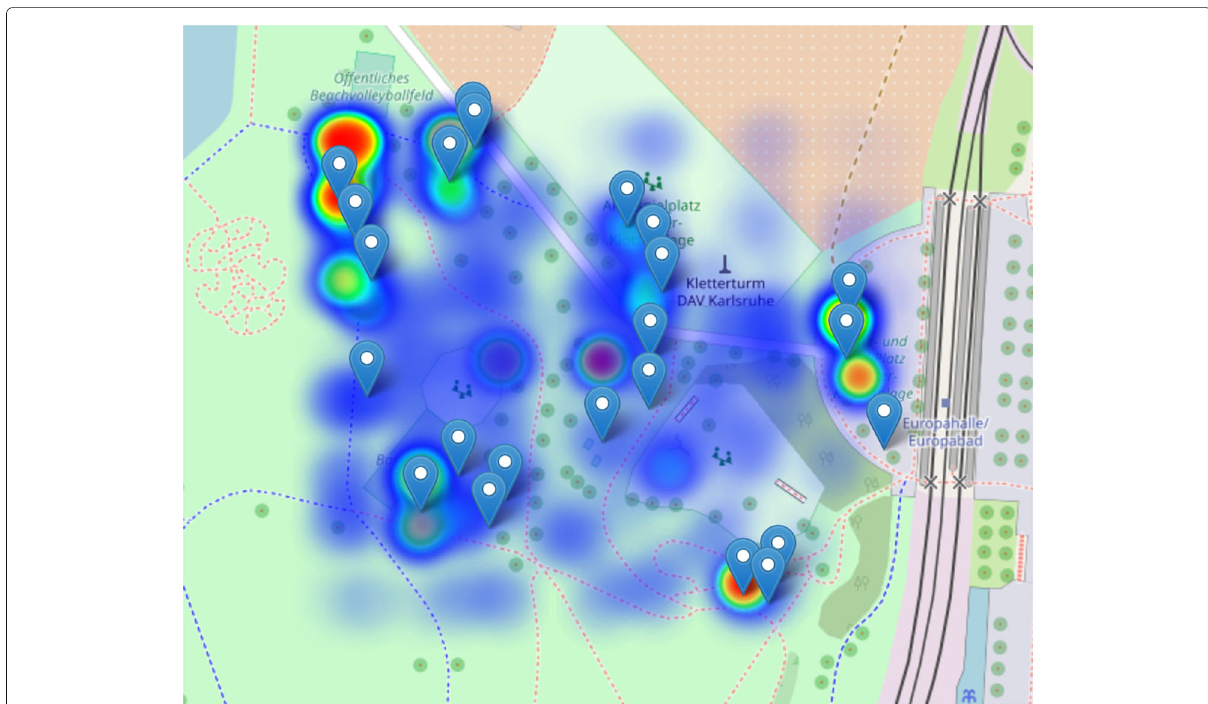
Fig. 6 View of the heatmap. Heatmap at the peak of the festival according to the application